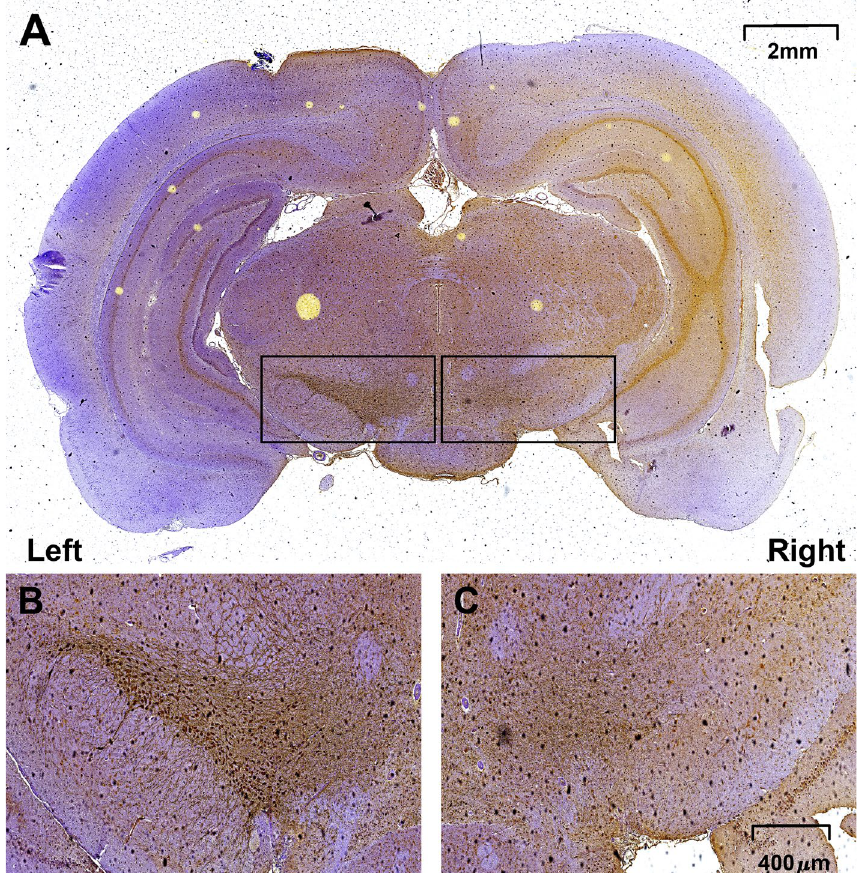
Figure 1. Loss of TH + neurons in medial forebrain bundle (mfb) after the injection of 6-OHDA. The injection in the right side reduces TH + neurons while the left side maintains its